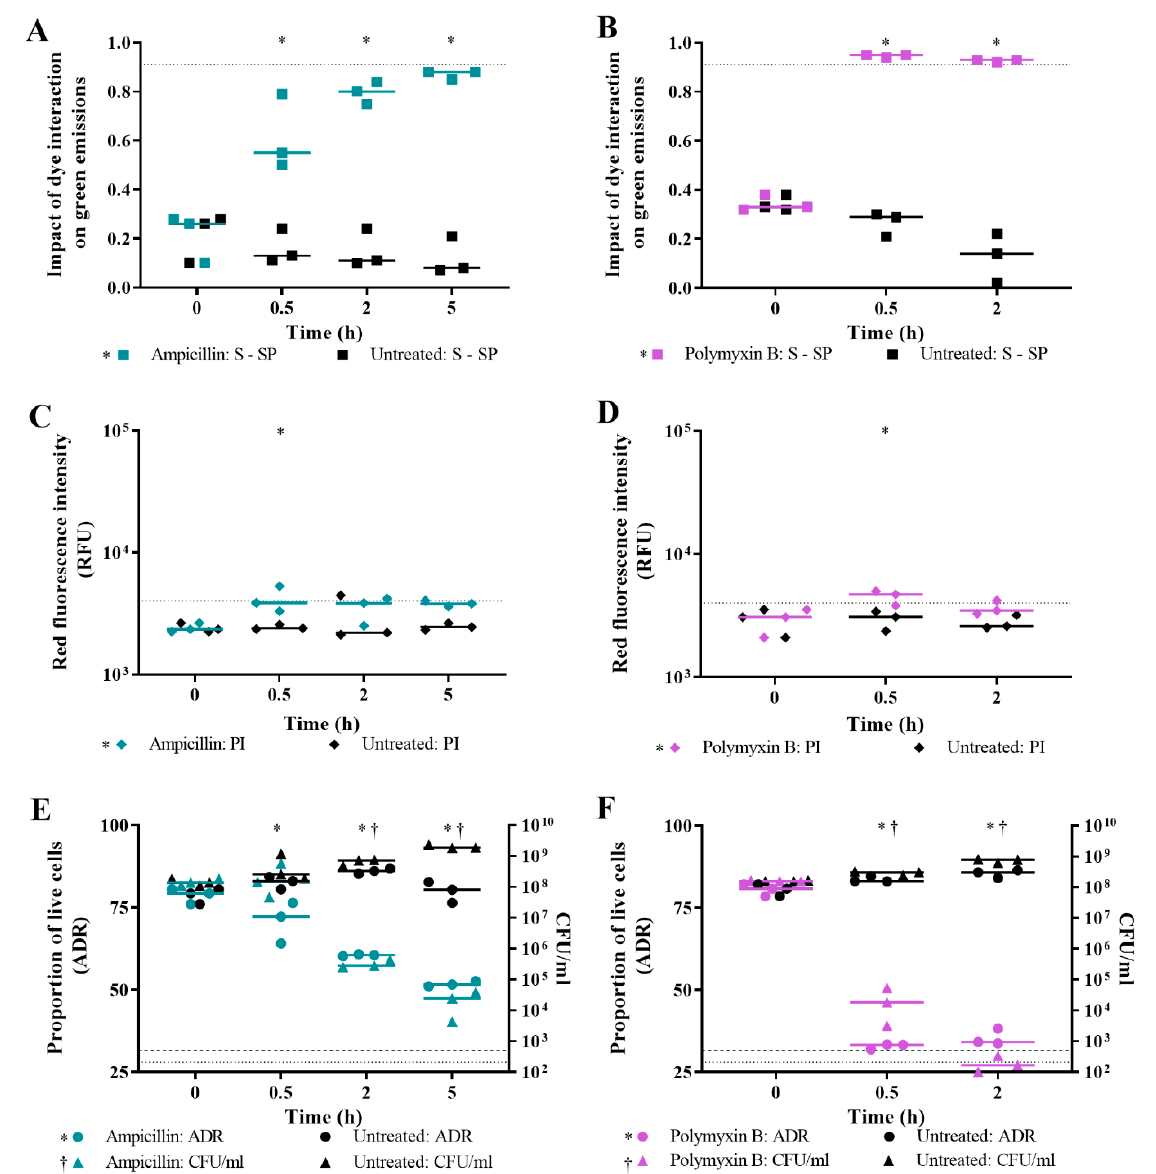
Figure 4. Live/dead spectrometry and culture-based enumeration of E. coli challenged with lytic antibiotics. At 0 h, 0.5 h, 2 h, and 5 h time points, viability of E. coli MG1655 challenged with ~1 × MBC of ampicillin (teal), polymyxin B (purple), and an untreated control (black) was determined by measuring fluorescence of SYTO 9- and/or PI-stained cultures using the Optrode ( A – F ) and by culture-based enumeration ( E , F ). Fluorescence intensities were obtained from integrating 505–515 nm for green emissions and 600–610 nm for red emissions. The proportion of live cells in the sample population was determined by the impact of the quenching/enhancement dye interaction on green emissions ( A , B ); level of red emissions ( C , D ); and the adjusted dye ratio (ADR; E , F ). The dotted lines represent the equivalent value for isopropanol-killed cells. The limit of detection for culture-based enumeration is 500 CFU/mL (dashed line). Data presented is from three biological replicates with a line plotted at the median. Statistical significance for the difference between treated and untreated at each time point is represented by * for fluorescence and † for plate counts (two-way RM ANOVA, p value: <0.05, Sidak’s multiple comparisons test).